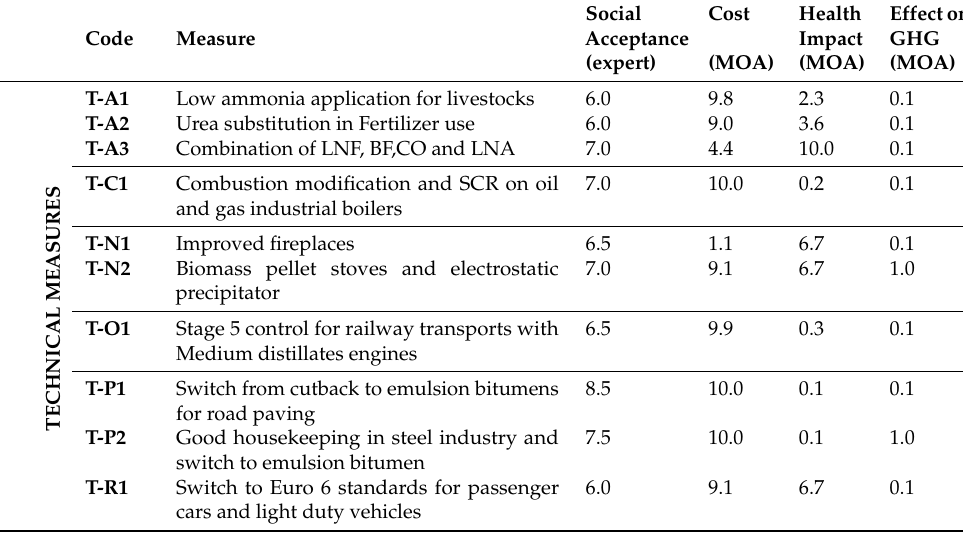
Table A4. Performance matrix containing the scores for each abatement measure in the four different criteria considered. (EXP) and (MOA) indicate which criteria have been evaluated respectively by experts or through multi-objective